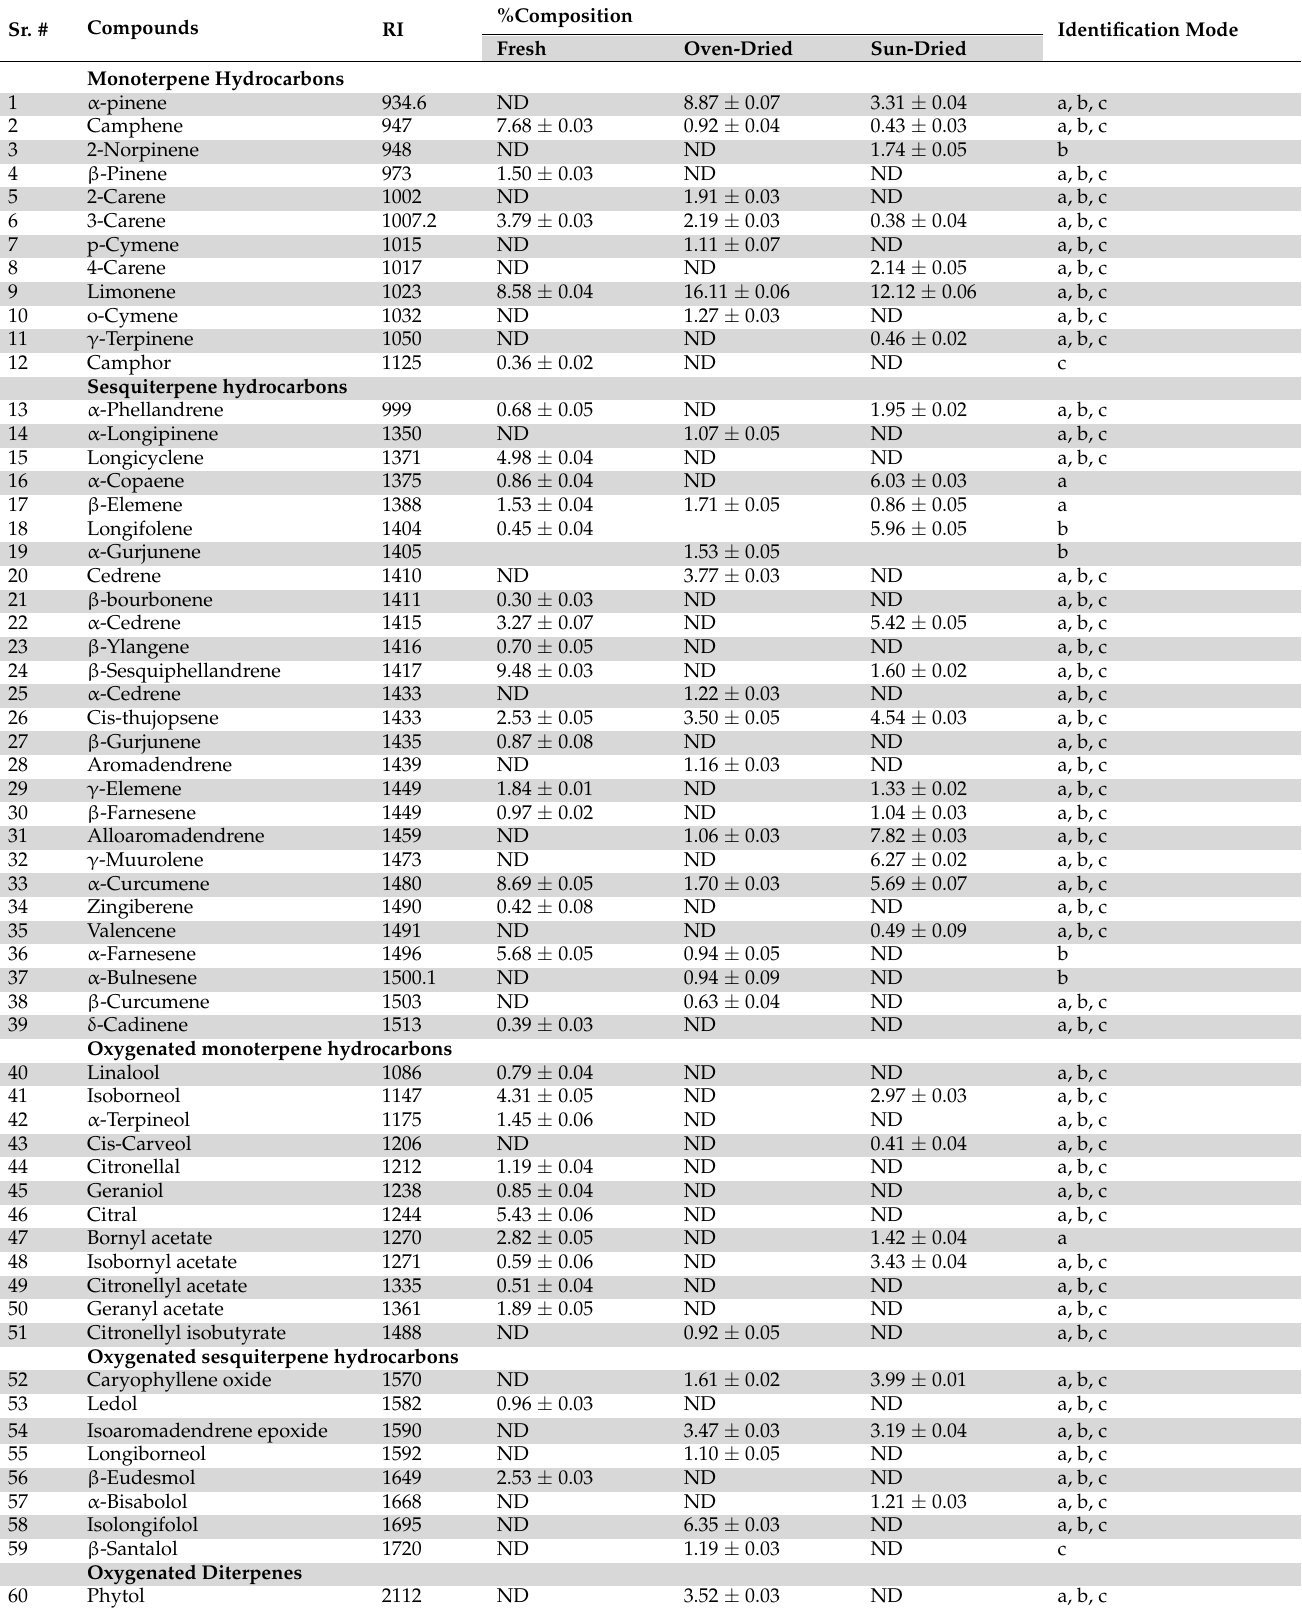
Table 3. Chemical composition of essential oil of ginger from Chinese